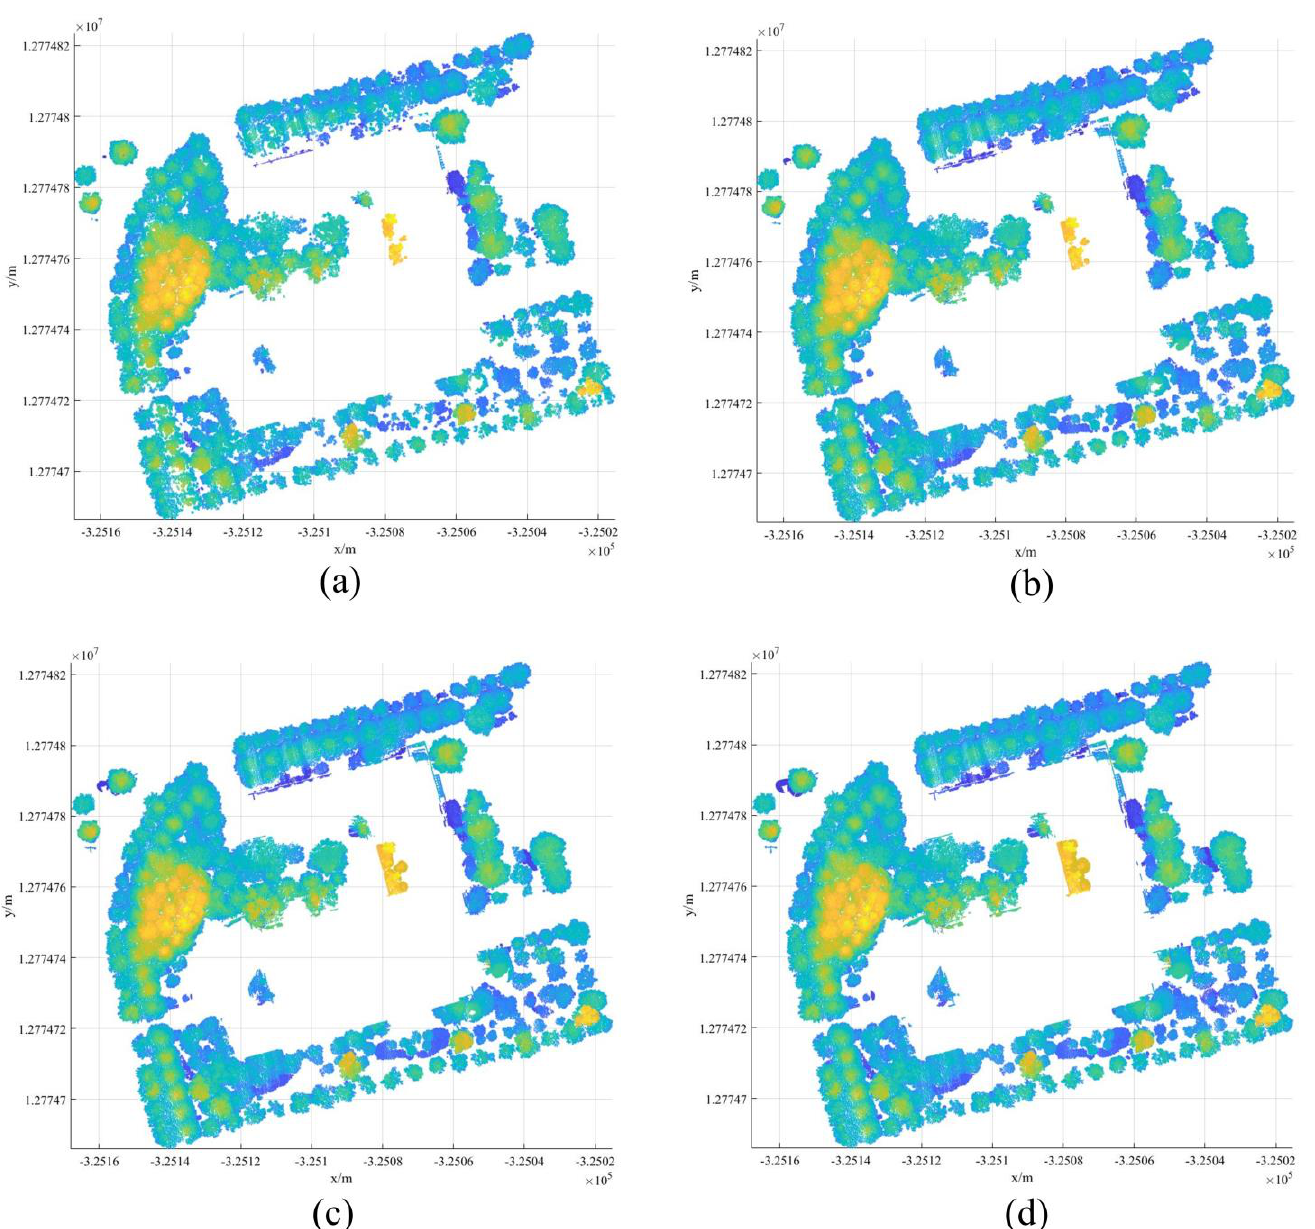
Figure 11. Vegetation extraction results of plot 1 at different r scales. ( a ) r = 0.5 m; ( b ) r = 1 m; ( c ) r = 1.5 m; ( d ) r = 2 m. Table 1. The recall and precision evaluation results of plot 1.